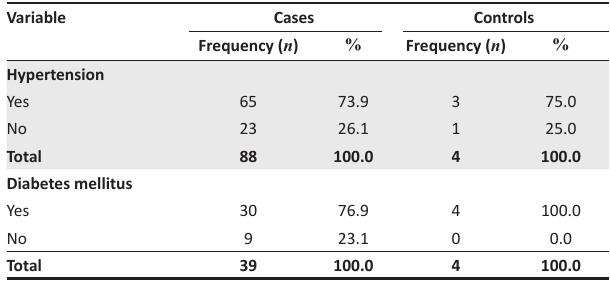
TABLE 5: Use of traditional medicines for treatment.